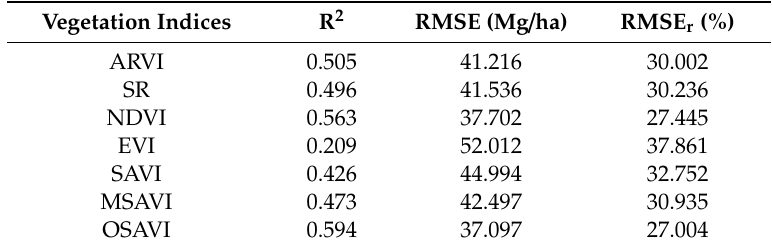
Table 3. Accuracy assessment of the models with input variables of SVIs.